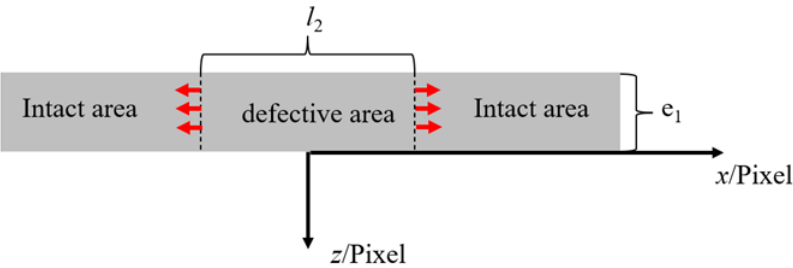
Figure 10. A schematic diagram of heat conduction in TBCs with defective area during cooling process. Red arrow denotes the direction of heat flow diffusion.